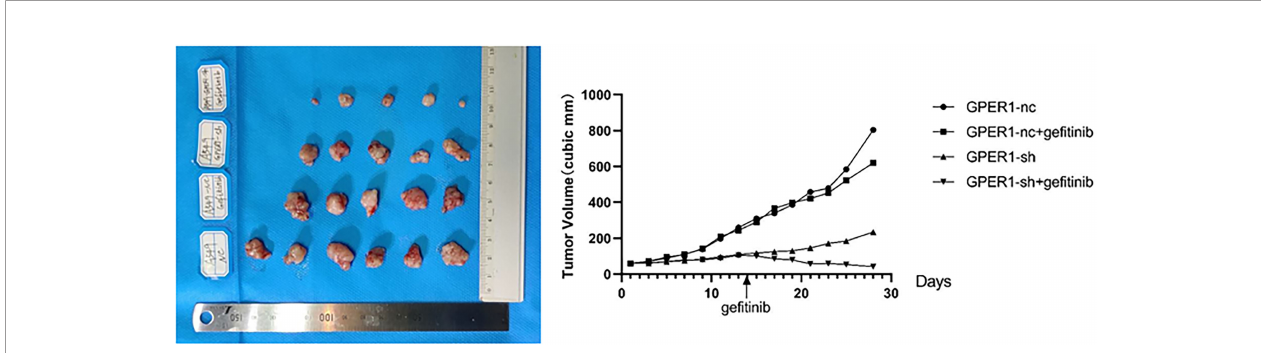
FIGURE 7 | Knockdown of GPER1 inhibited growth of EGFR-TKIs resistant tumor, and improved the ef fi cacy of ge fi tinib. GPER1 negative control short hairpin RNA (GPER1-nc), GPER1 short hairpin RNA